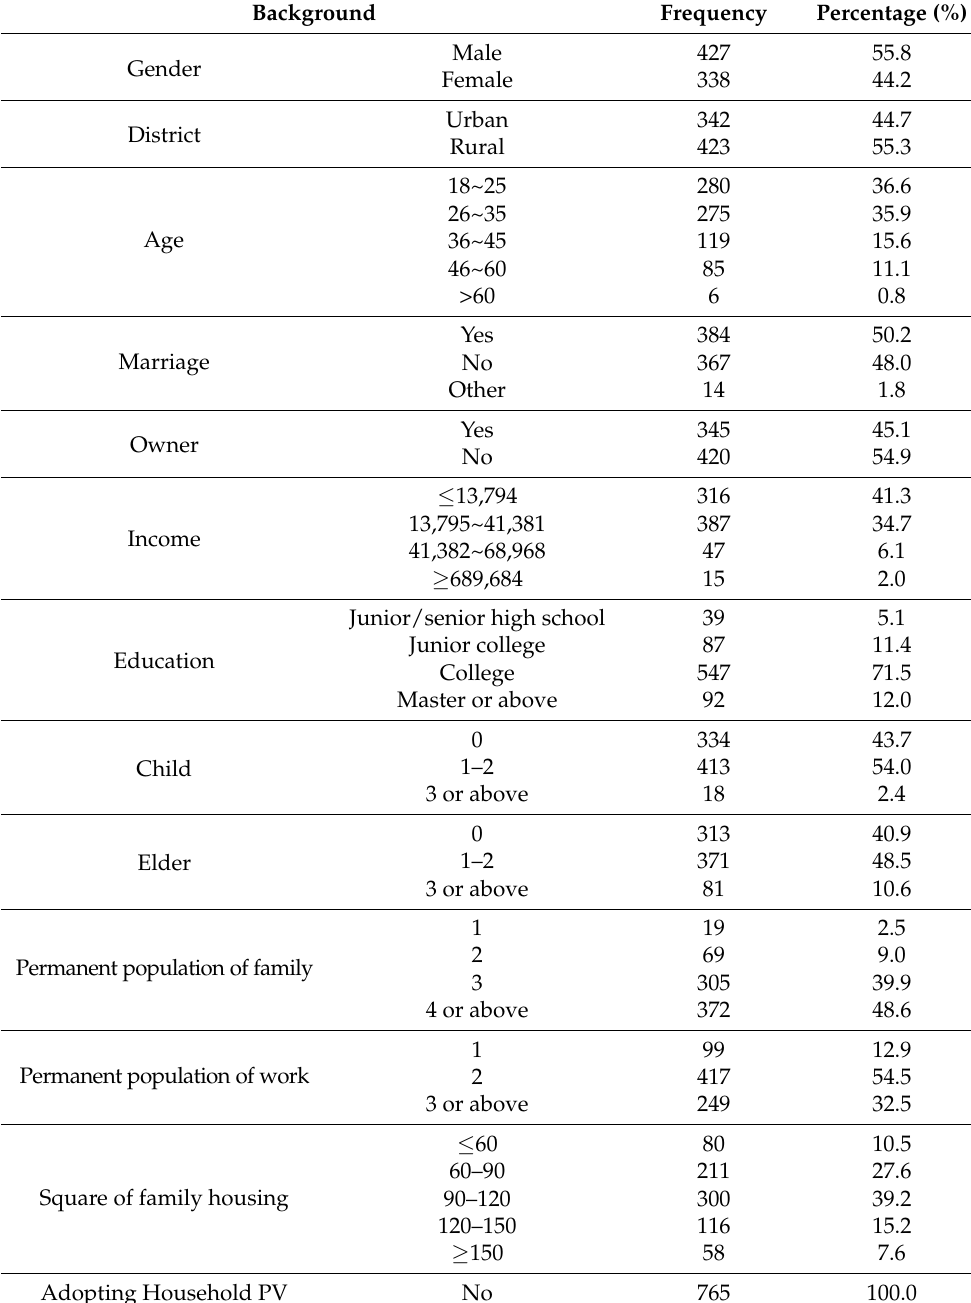
Table 5. Summary of sample demography (N =